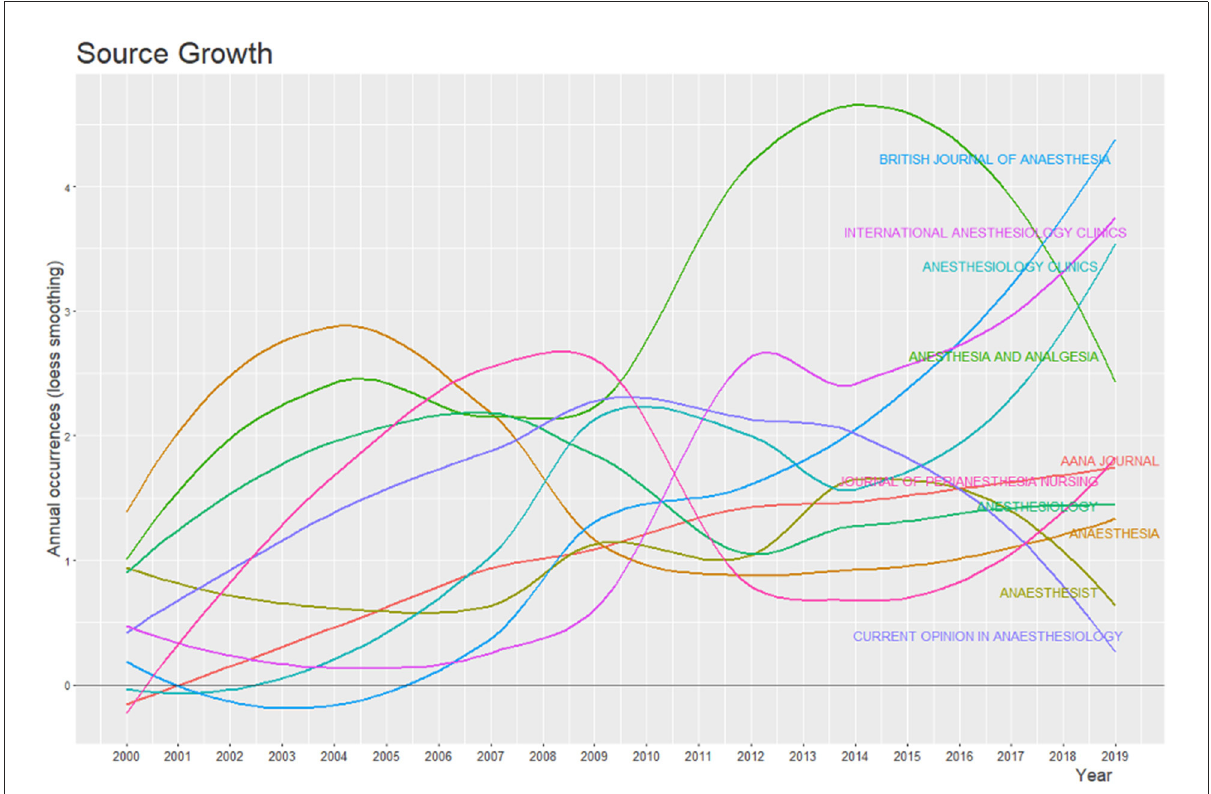
FIGURE4 Annual occurrences of publications in the most relevant sources. To enhance legibility of the plot, the number of source dynamics was restricted to the 10 most relevant